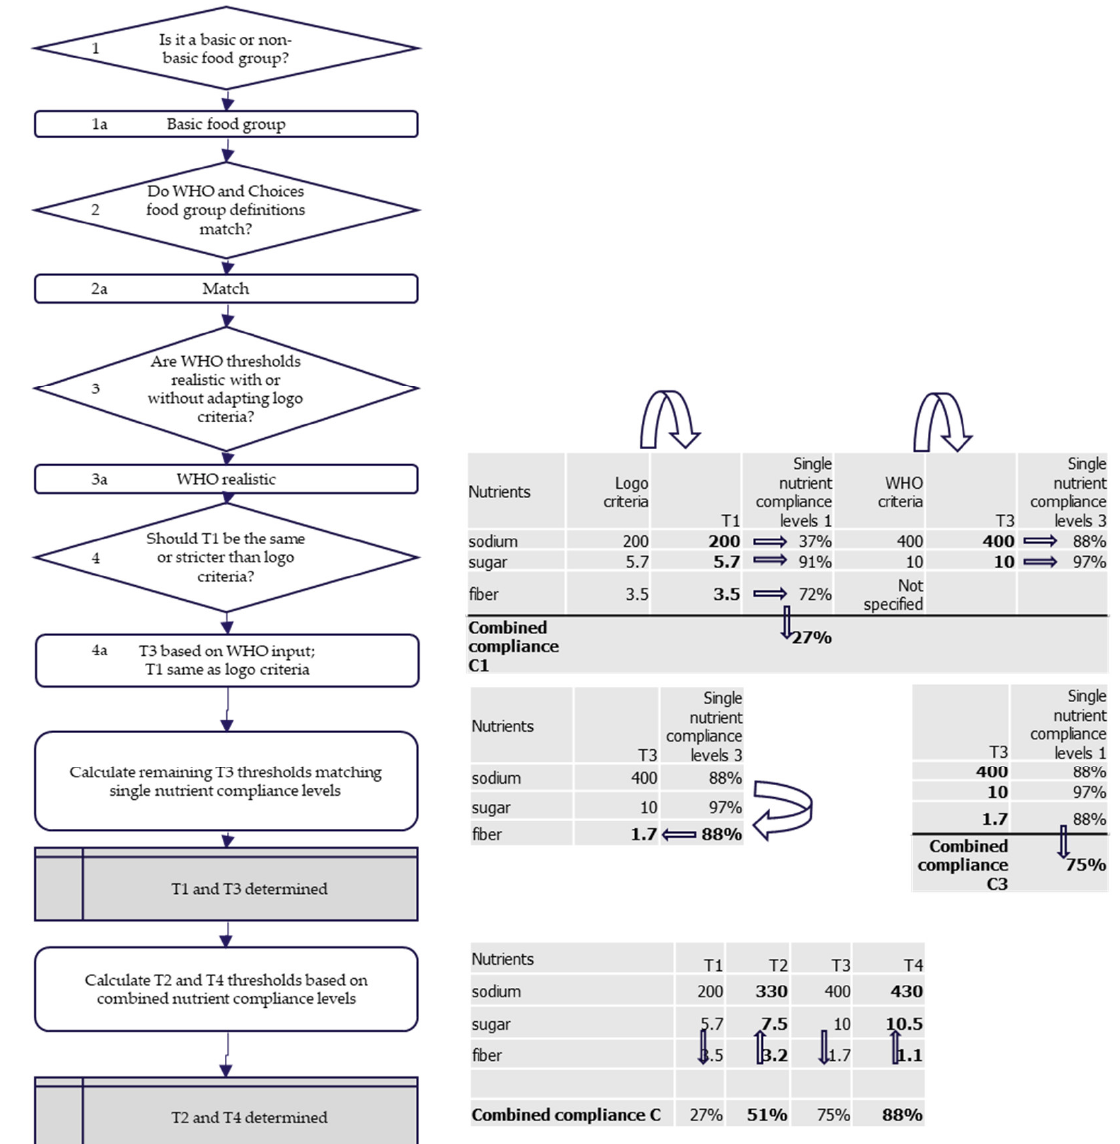
Figure 4. Illustration of how the thresholds T1–T4 for sodium, sugar, and fiber were determined for the food group ‘processed beans and legumes’. This food group is a basic food group (step 1) and the WHO uses a similar food group definition (step 2). T1 sodium and sugar thresholds are at least 50% stricter than WHO criteria, and a combined compliance level C1 = 27%, i.e., 27% of products in the database complying with these T1 thresholds, was considered realistic (step 3 and 4). Therefore, it was decided to use the logo criteria for T1 and use WHO as input for T3 (decision 4a). As the WHO does not provide a threshold for fiber, T3 for fiber is determined by matching single nutrient compliance (88%) with other single nutrient compliance levels, resulting in a value for T3 fiber = 1.7. Now all T3 threshold values have been determined, the combined compliance C3 = 75% is calculated. C1 and C3 are then used to determine C2 (51%) and C4 (88%), as described in the text, which are used to determine T2 and